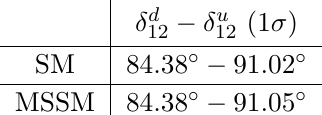
including running effects within the SM and the − δ u 12 12